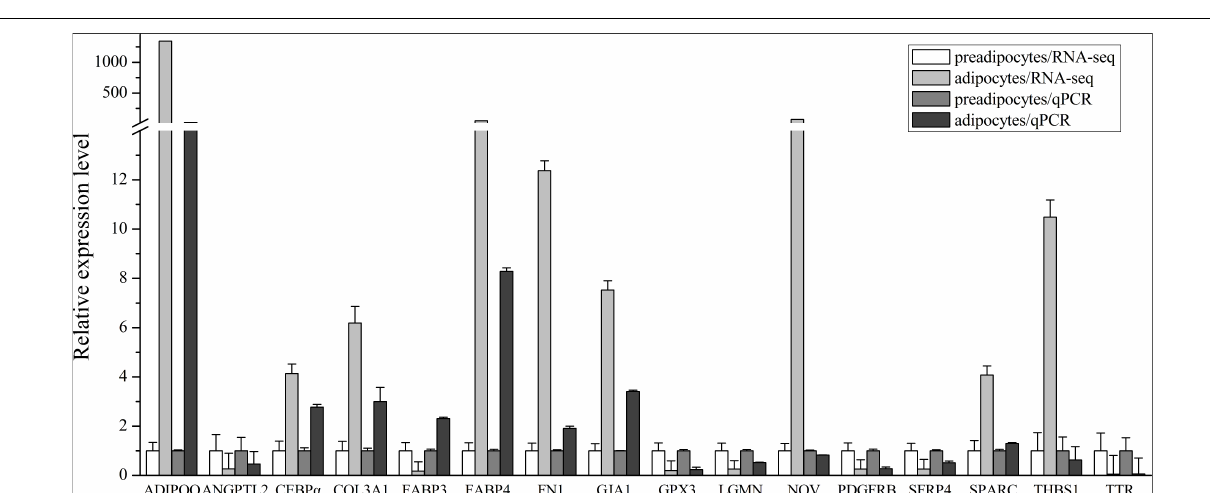
FIGURE 5 | Protein interaction networks encoded by DEGs enriched in the top 3 KEGG pathways. Red and green points represent genes up-regulated and down-regulated, respectively.